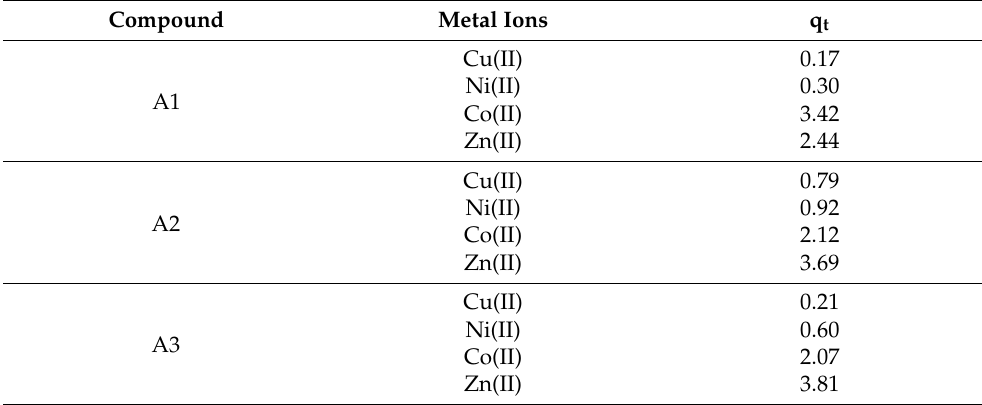
Table 8. The sorption capacity of membrane with ligands A1–A3 after 24 h of sorption.